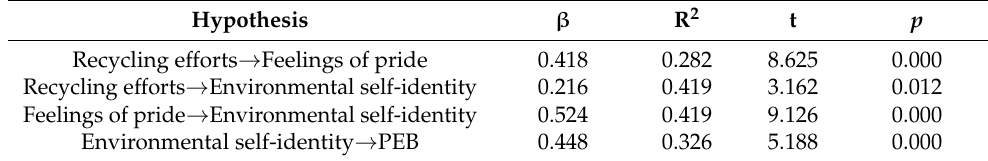
Table 3. Path analysis of